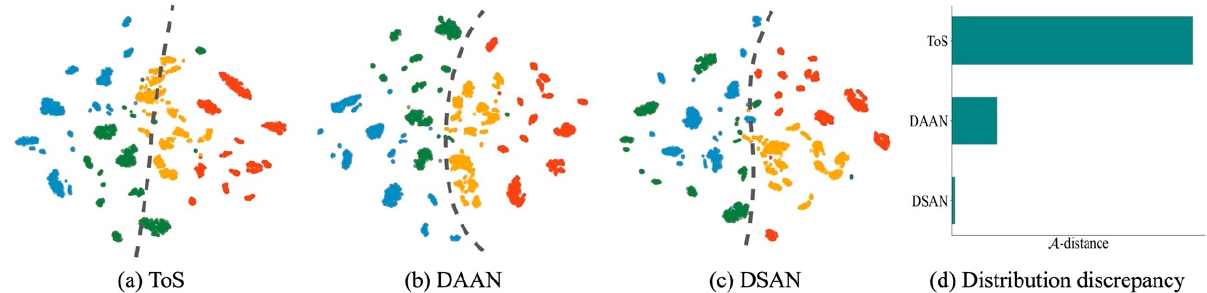
Figure 3. ( a – c ) Visualizations of the learned feature representations using t-SNE on task M → K w/or w/o UDA. The red and yellow circles represent the source and target domain fire samples, respectively. The blue and green circles represent the source and target domain non-fire samples, respectively. The grey dashed lines indicate possible classification boundaries. ( d ) Distribution discrepancy between domain M and K measured by A-distance.